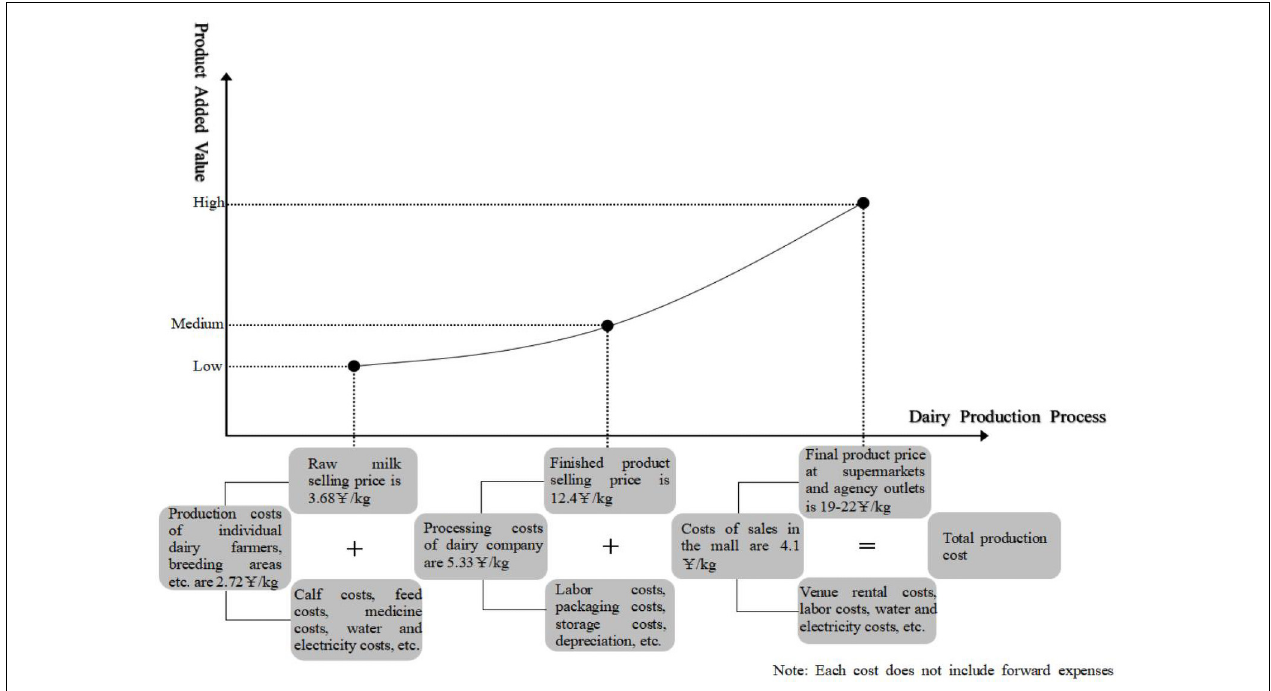
FIGURE 7 | Dairy production cost breakdown.